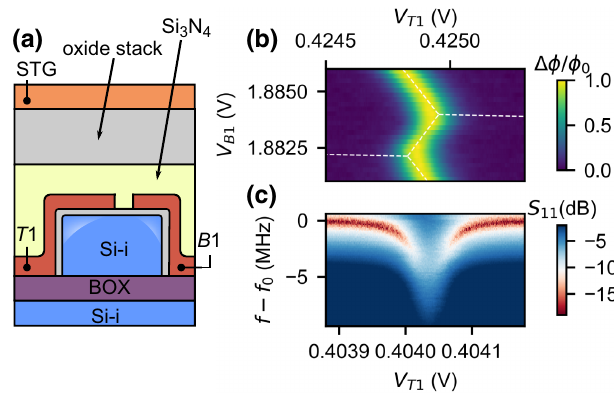
FIG. 13. Large dispersive interaction in a NWFET with a super-top gate (STG). (a) Cross-section schematic of the NWFET, similar to Fig. 1(b), but with an additional gate STG above the split gate. (b) Reduced phase response of the resonator (cid:9)φ/φ 0 in the region of an ICT. (c) Magnitude of the signal reflected from the cavity showing the shift in the resonant fre- quency as V T 1 is swept across the ICT. Note the change in V T 1 axes is due to a change in the V STG setting: V STG = 11.15 V in (a) and 12.1 V in